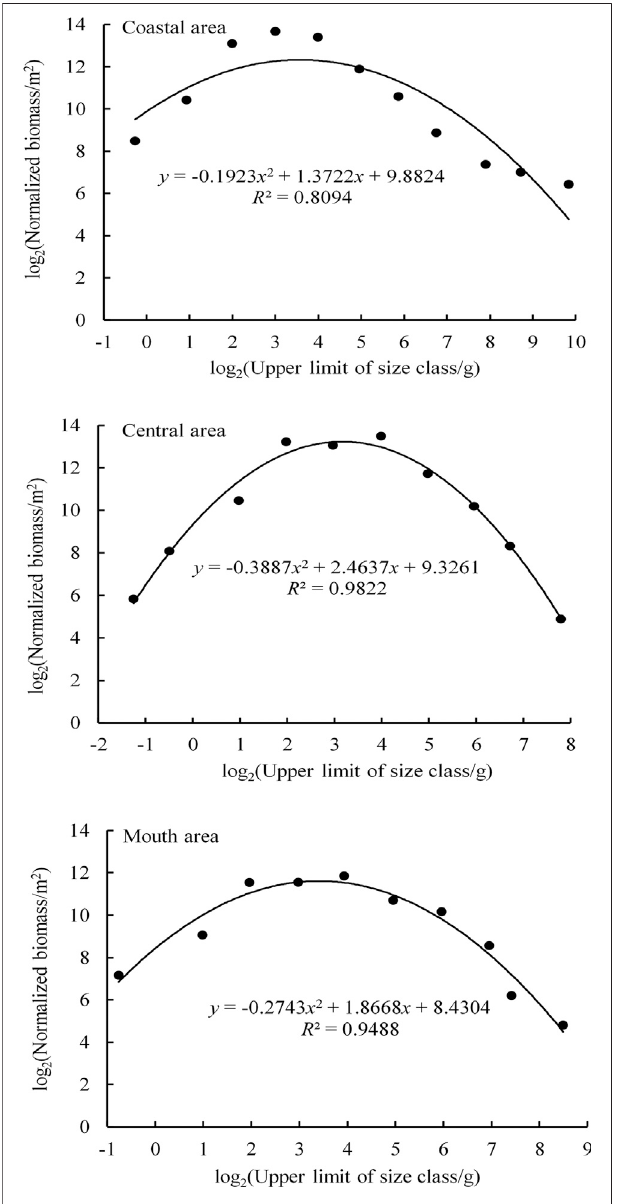
FIGURE 9 | Normalized biomass size spectra of fi sh in different regions of Daya Bay.